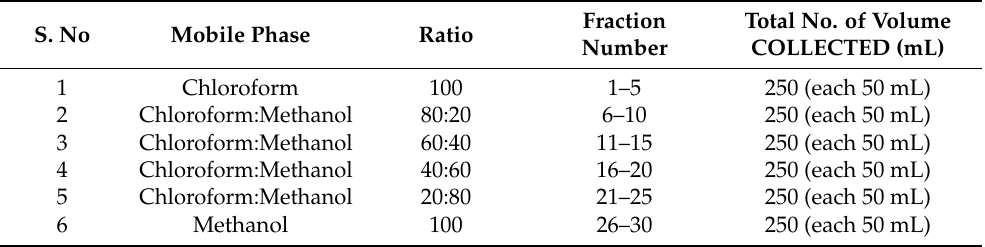
Table 1. Solvents used for purification from Leucas indica using column (silica: 20 mm)